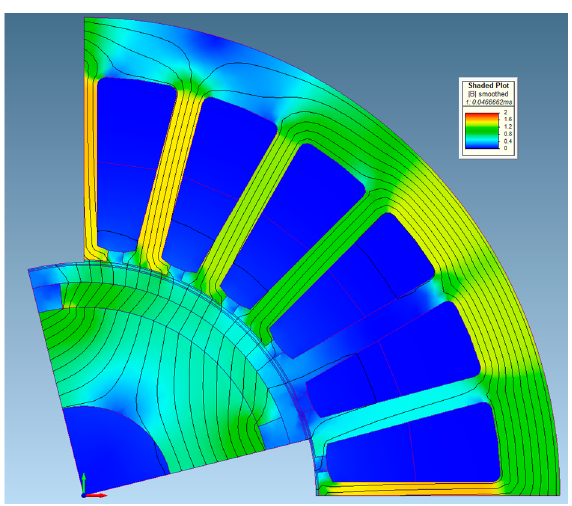
Figure 11. Flux lines and flux density distribution of Mot24 2 with rated current.